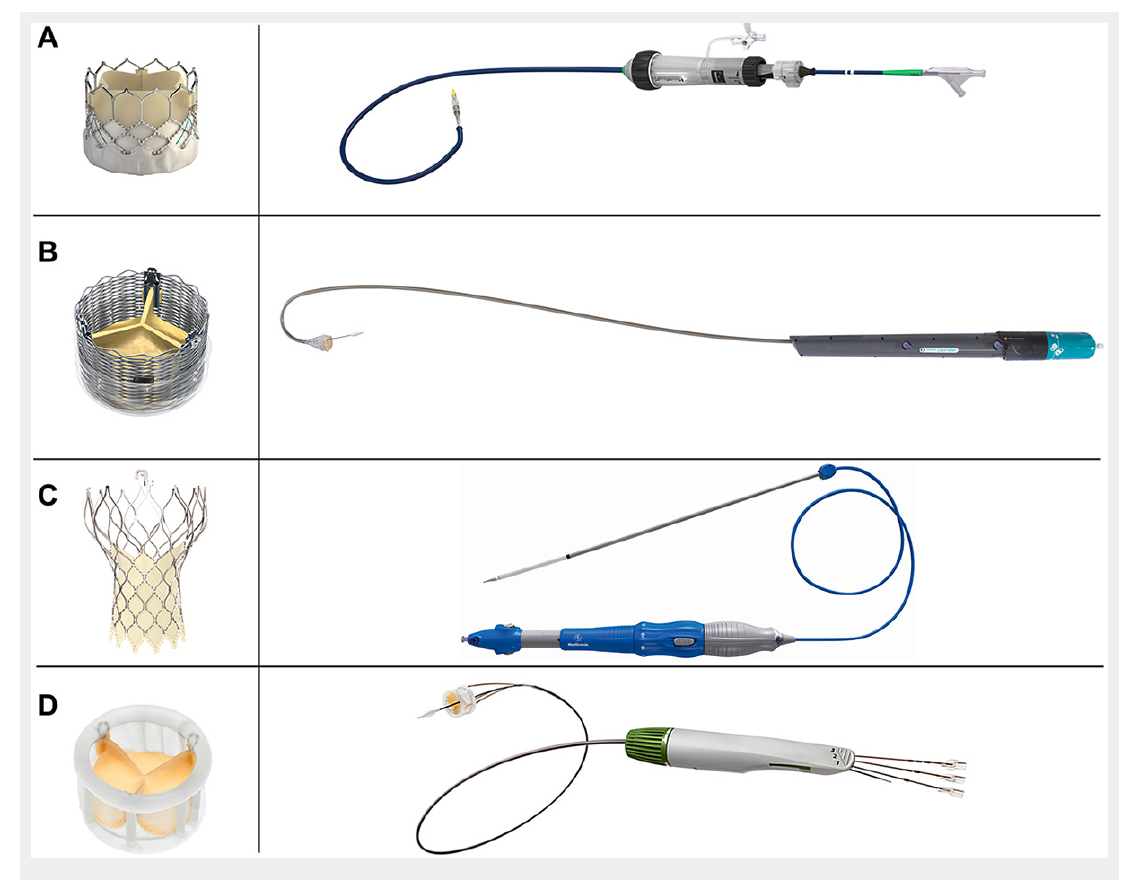
Figure 3 Routinely used second generation devices and delivery catheters. Commonly used second-generation transcatheter aortic valve implantation devices and delivery catheters. A: the Edwards Sapien 3 bioprosthesis – Commander delivery catheter. The sealing skirt is designed to minimise paravalvular leakage (images courtesy of Edwards Lifesciences); B: the fully repositionable premounted Boston Scientific Lotus valve and its preshaped delivery catheter (images courtesy of Boston Scientific); C: the resheathable Evolut R valve with the EnVeo R delivery catheter and the integrated InLine Sheath (images courtesy of Medtronic); D: The Direct Flow valve and delivery system (images courtesy of Direct Flow